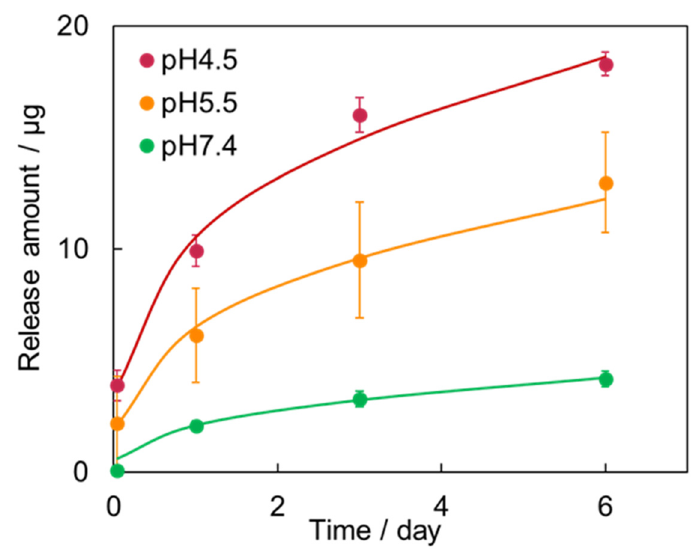
Figure 5. Vitamin K ₁ -releasing behavior of PLHA-V200 in phosphate buffer at various pH levels. Error bars represent the standard deviation ( n = 3). Solid lines represent Korsmeyer–Peppas fitted release profiles.